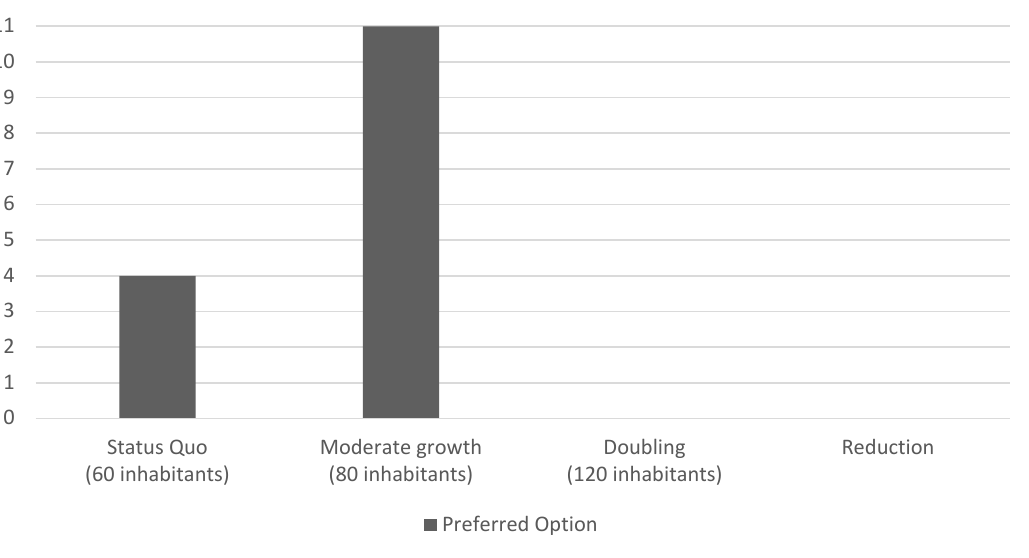
Figure 17: Results of the question on the preferred population scenario for Kirchbühl The preferred population scenario with moderate growth from 60 to around 80 inhabitants (11 out of 15 votes) was integrated into the target image.